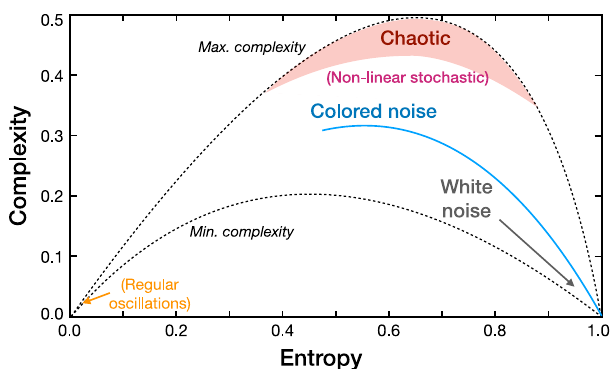
Fig. 2 Graphical representation of the complexity – entropy plane. Graphical representation of the plane as proposed by Rosso et al. 71 , and of the approximate position of chaotic systems, and coloured and white noises. Dynamics in parenthesis (i.e. non-linear stochastic and regular oscillations) were not included in the